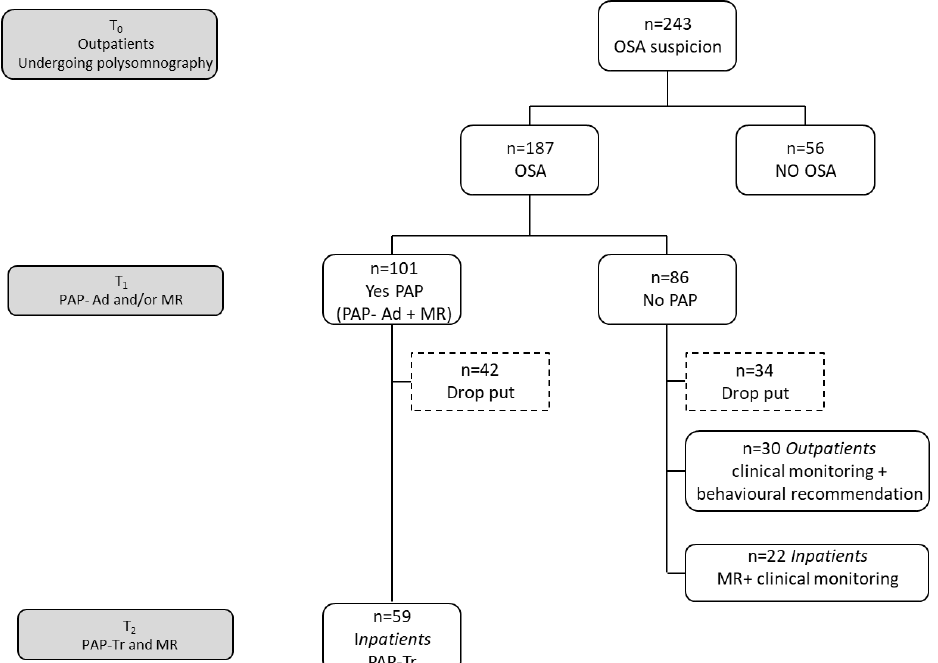
Figure 1. Flow diagram of research timing and subdivision of subjects according to diagnosis and treatment. Abbreviations: PAP-Ad, PAP adaptation; MR, multidisciplinary rehabilitation; PAP-Tr, PAP treatment.